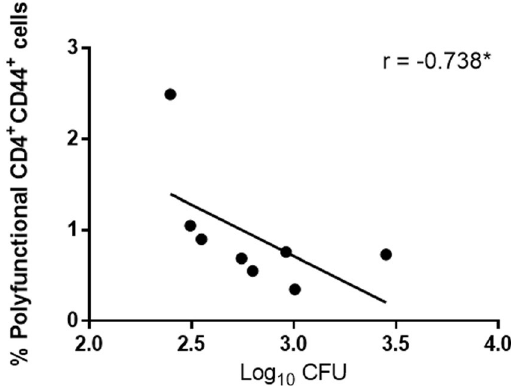
Figure 7. Association between polyfunctional T cells and mycobacterial growth inhibition. Scatter plots of the frequency of IFN- γ + TNF- α + IL-2 + polyfunctional CD4 + cells at day 0 from the experiment shown in Fig. 6a versus H56:CAF01 induced growth inhibition data from the same experiment. Spearman’s rank * p <